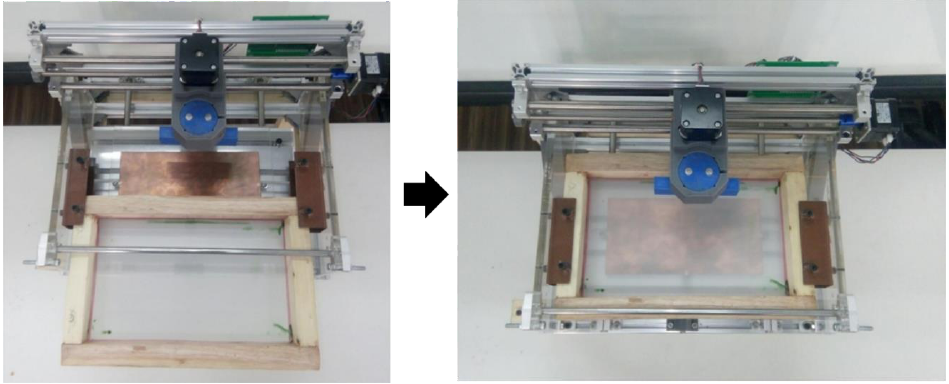
Figure A7. Images of the screen printing equipment with frame and printed circuit board (PCB).